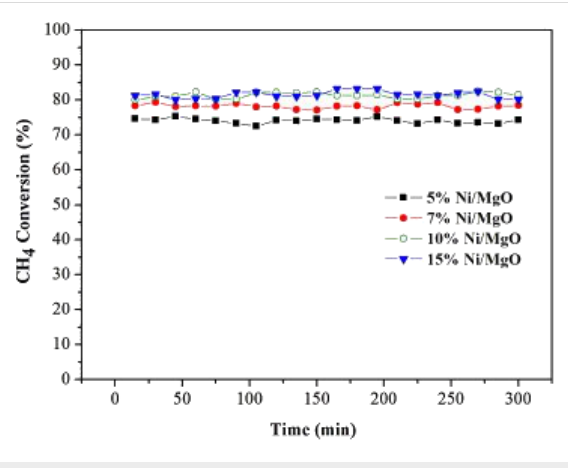
Figure 11: Stability of CH 4 conversion over Ni/MgO catalysts with dif- ferent Ni loadings (5% to 15%) in a DRM reaction at 700 °C, CH 4 /CO